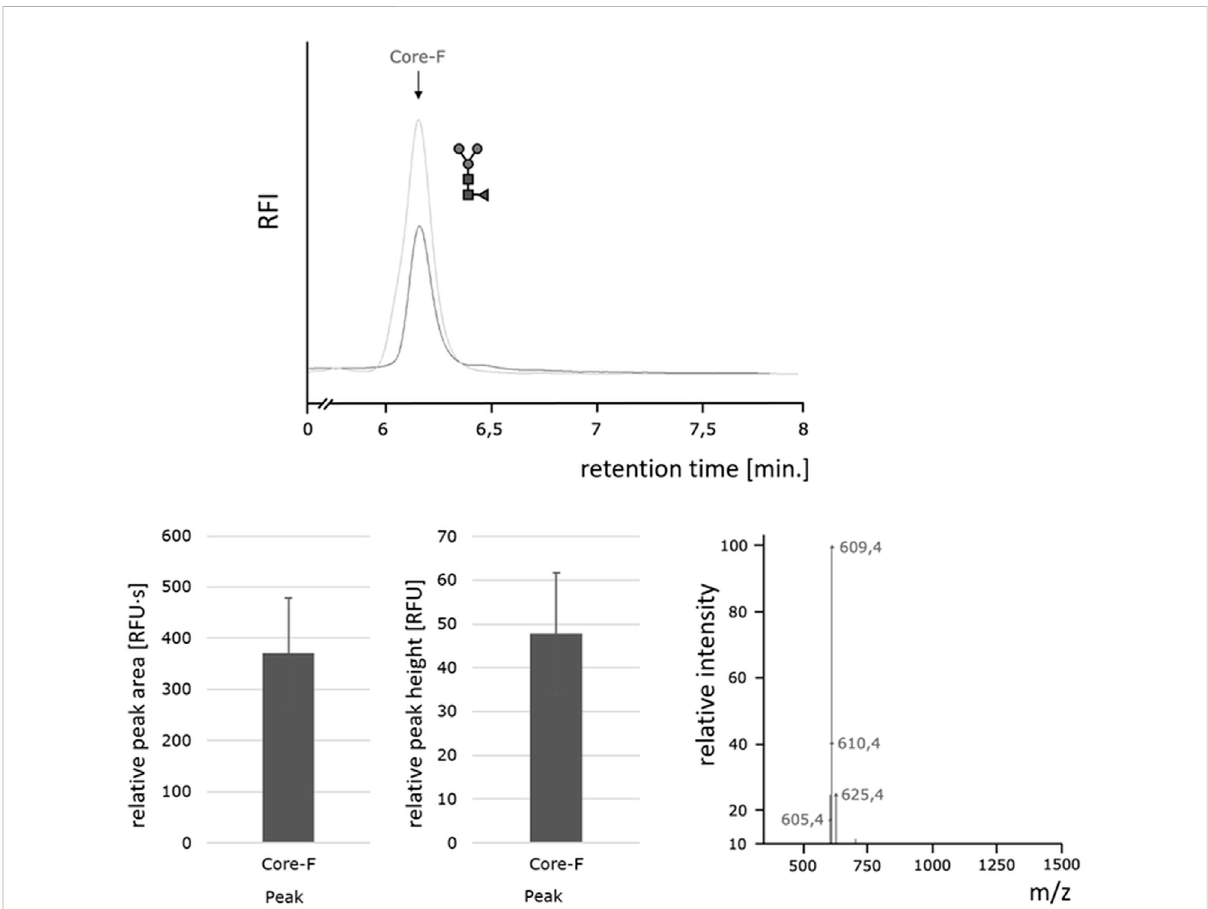
FIGURE 8 Homogeneous paucimannose core-F N-glycans released by the Oxone ® /Bromide method. Top: HILIC-FLD peak pro fi les for 2-AA-labeled N-glycans released from RSVF by either PNGase F (light grey trace) or Oxone ® /Bromide (dark grey trace). Column: OTU Amino 250 × 4.6 mm, isocratic solvent: 60 % ACN / 10 mM ammonium formate (pH 4.4), fl ow rate: 0.5 ml/min., column temperature: 40 ° C, fl uorescence detection: λ ex = 360 nm, λ em = 420 nm; GAIN 100. Bottom left: Mean values and standard deviation for peak area (left) in relative fl uorescence units x second [RFU · s]andpeakheight(right)inrelative fl uorescenceunits[RFU]forthecore Fpeak(with n =3).Bottomright:Positive ionmodem/zdataforthe2- AA labeled core-F